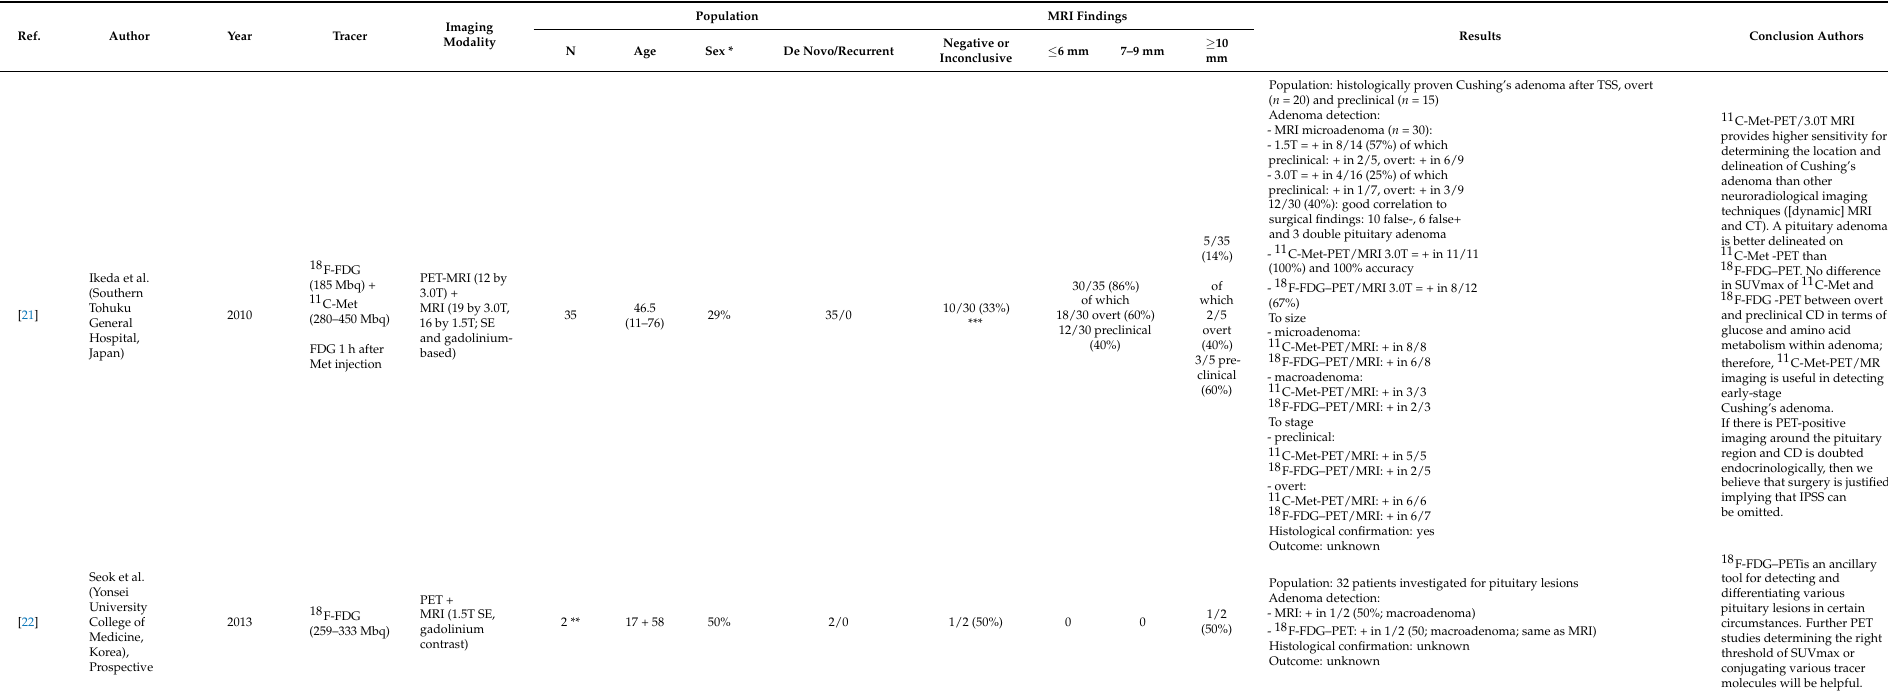
Population: 32patientsinvestigatedforpituitarylesions Adenomadetection: -MRI:+in1/2(50%;macroadenoma) -18F-FDG–PET:+in1/2(50;macroadenoma;sameasMRI) Histologicalconfirmation: unknown Outcome: unknown